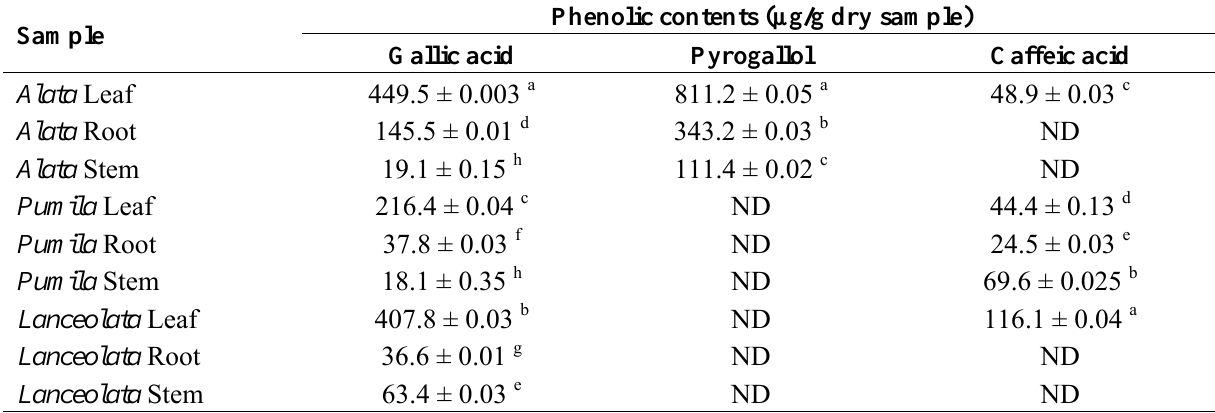
Table 2. Concentration of different phenolic compounds from methanolic extract of leaf, stem and root of three varieties of Labisia pumila Benth.